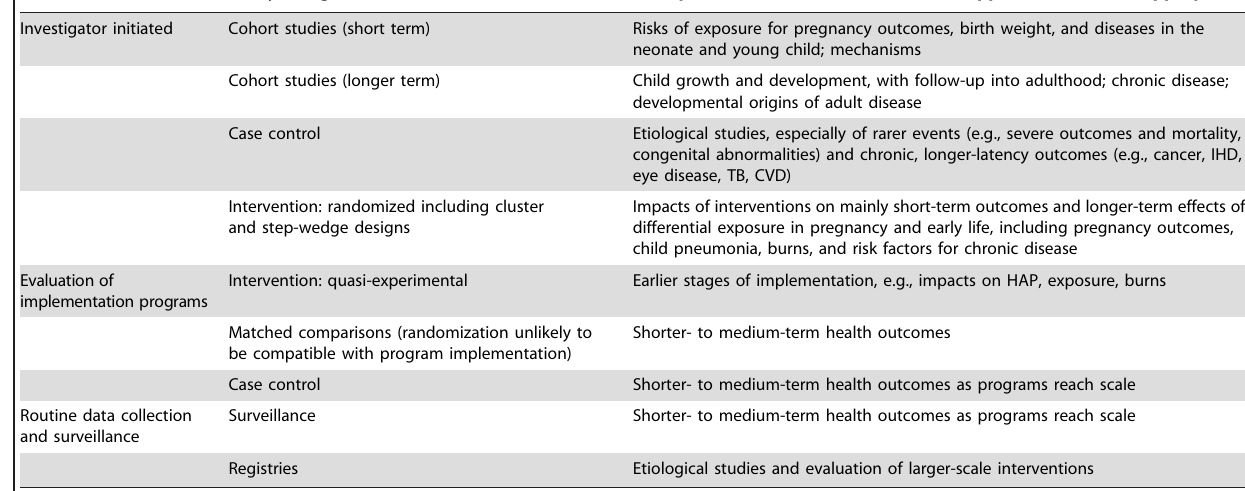
Table 3. Approaches and key study designs required to address research and evaluation